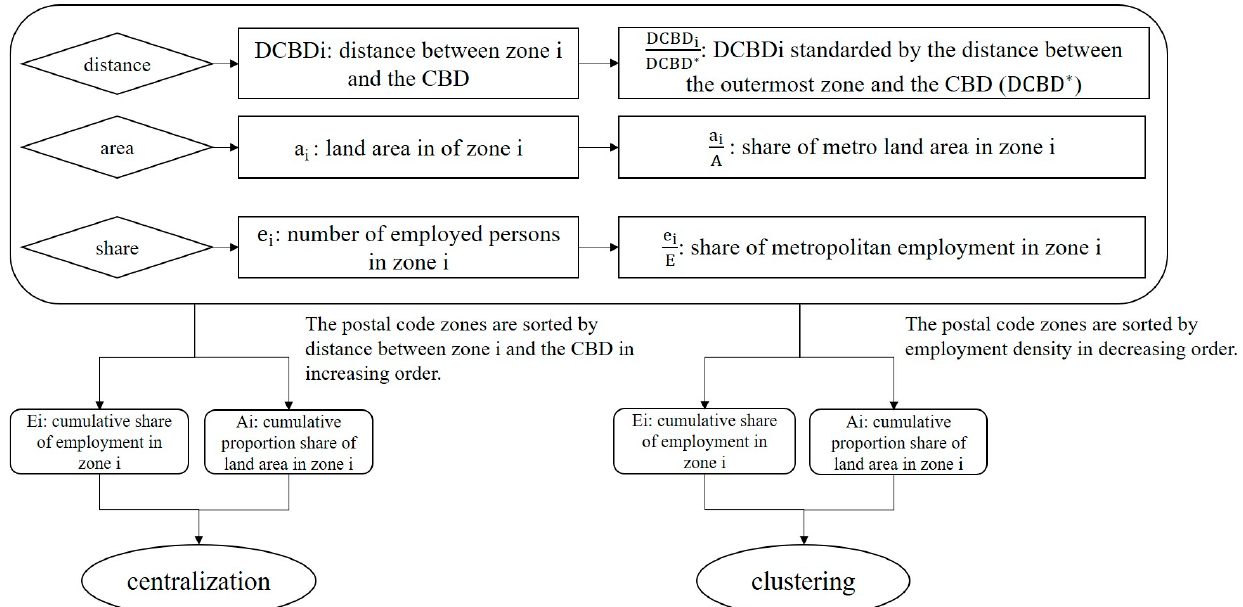
Figure 4. Calculation progress of centralization and clustering.